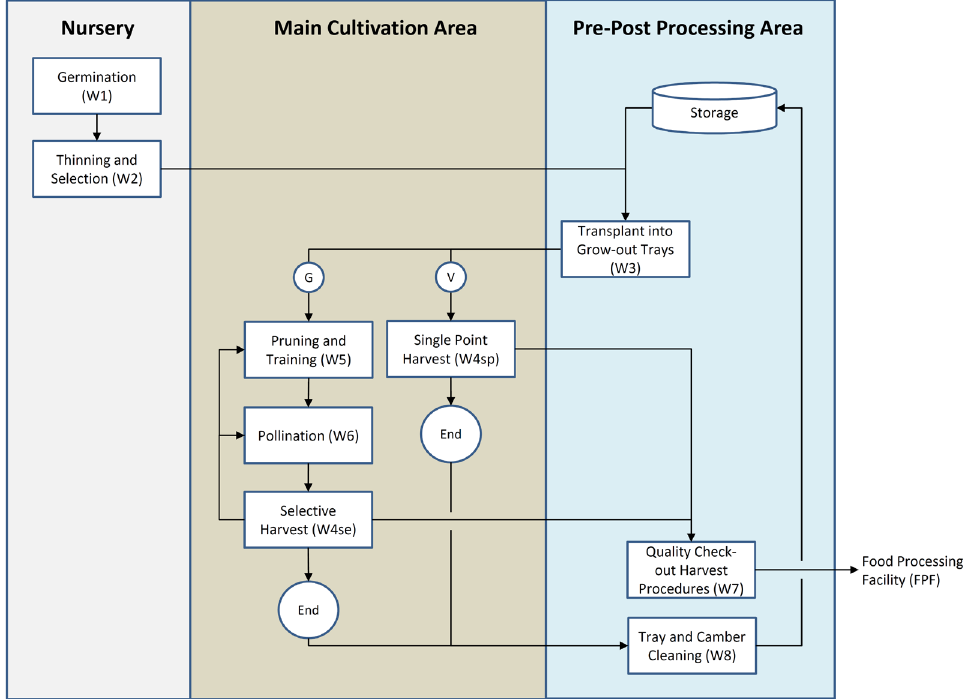
Figure 7: Overall work algorithm for the plant production process inside the FEG and service section. Three main work domains were established: Nursery tasks, main cultivation work tasks, and the pre- and post-processing tasks. Two types of crop cultivation are included: Vegetative crops (V) with a Single Point Harvest event (W4sp) and fruiting crops, entering the generative life cycle phase (G) with selective Harvest events